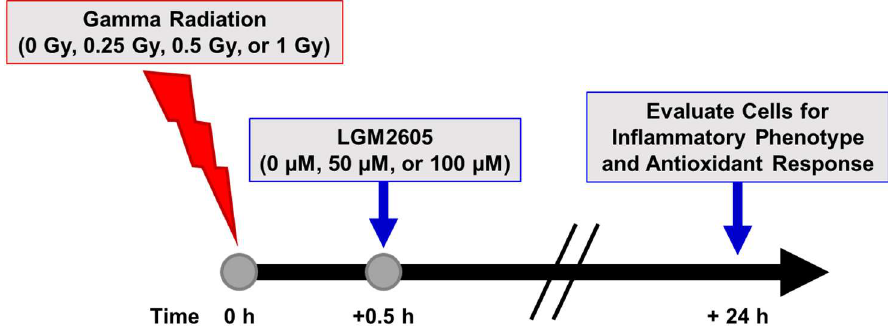
Scheme 2. Experimental plan of gamma radiation exposure of in vitro lung vascular networks (flow- adapted endothelial cells) and LGM2605 treatment. FAECs were exposed to 0 Gy, 0.25 Gy, 0.5 Gy, or 1 Gy gamma radiation and treated with 0 µM, 50 µM, or 100 µM LGM2605 30 min following radiation exposure. Cells were harvested 24 h post radiation exposure and evaluated for inflammation, inflammasome activation, and gene expression changes related to profibrogenic and antioxidant